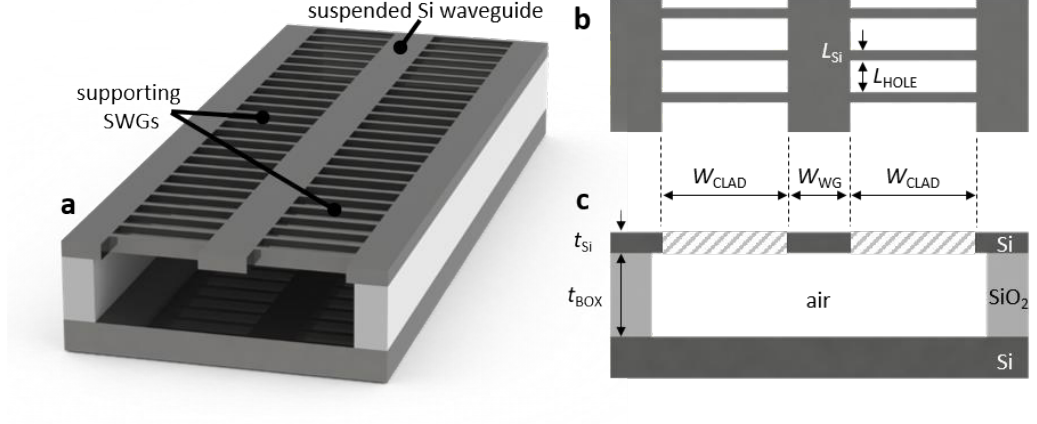
Figure 16. ( a ) 3D and ( b ) top view and ( c ) cross-sectional schematics of a suspended Si waveguide, which is supported by subwavelength